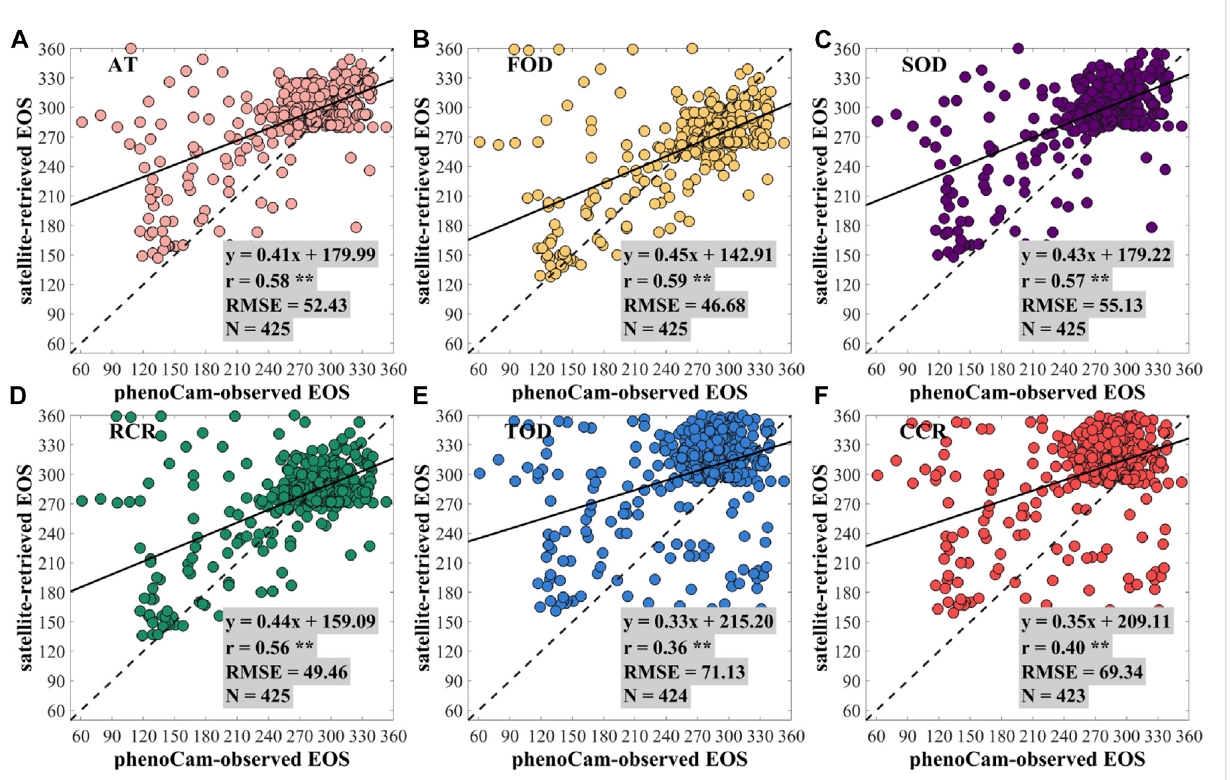
FIGURE 3 Scatterplots for the regression analysis between the PhenoCam-observed EOS and the satellite-retrieved EOS using the methods of (A) amplitude threshold (AT), (B) fi rst-order derivative (FOD), (C) second-order derivative (SOD), (D) relative change rate (RCR), (E) third-order derivative (TOD), and (F)